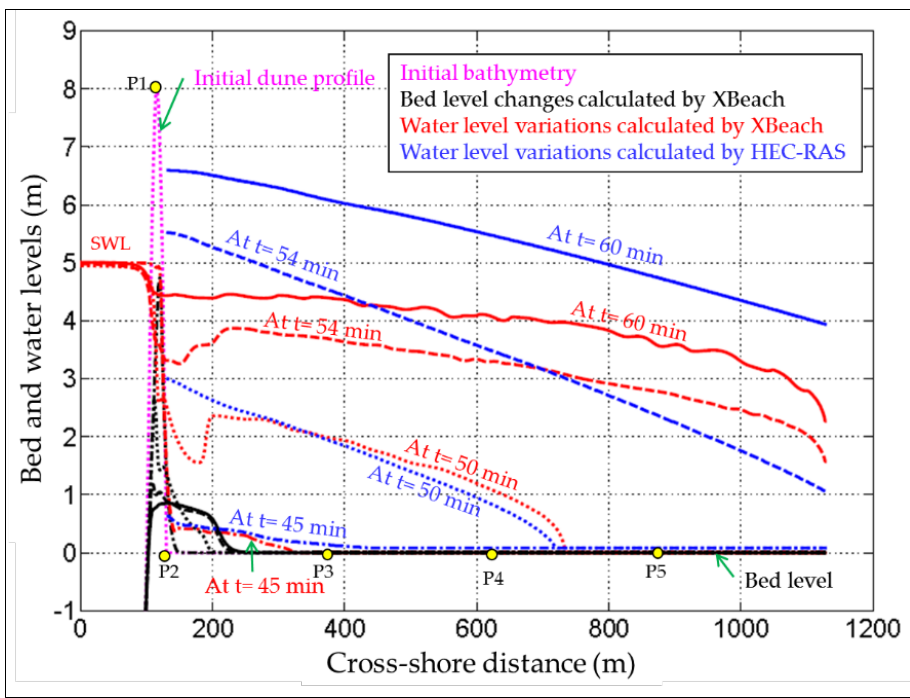
Figure 8. Comparison of water levels calculated by both HEC-RAS and XBeach (1D) at times 45, 50, 54 and 60 min under the rectangular load (LC1).